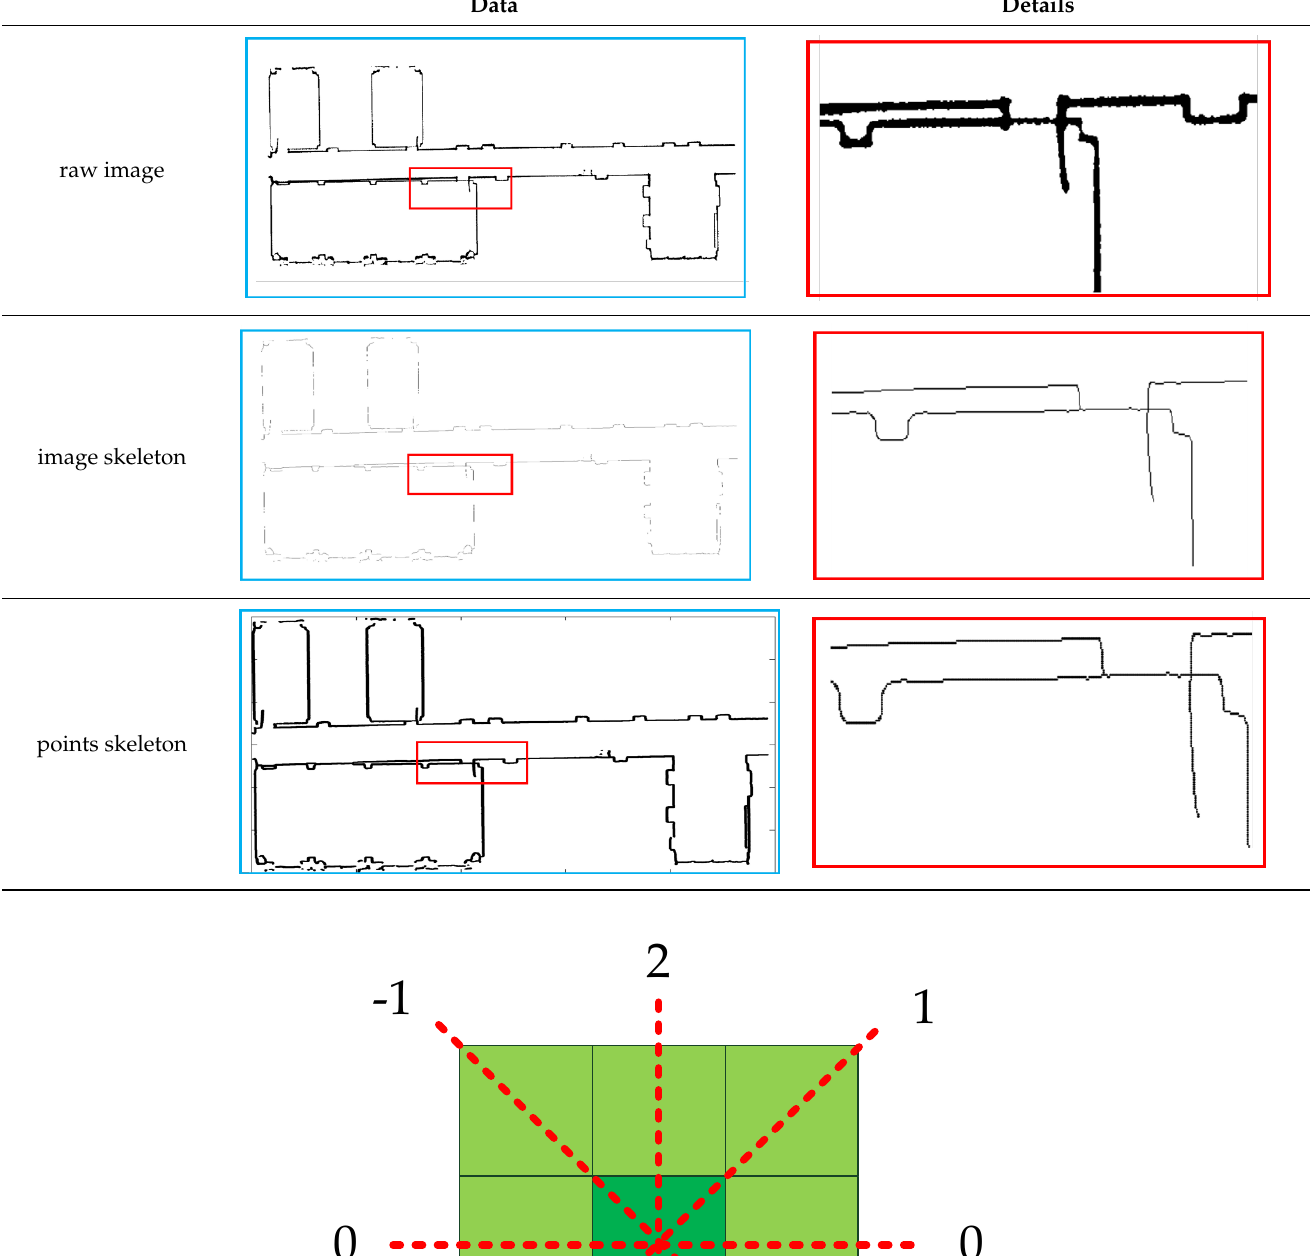
Table 3. Image skeleton extraction. The contour of the image is extracted by the skeleton extraction algorithm and lines are refined into single pixels. Similarly, the skeleton made up of two-dimensional points is reduced by the image skeleton.